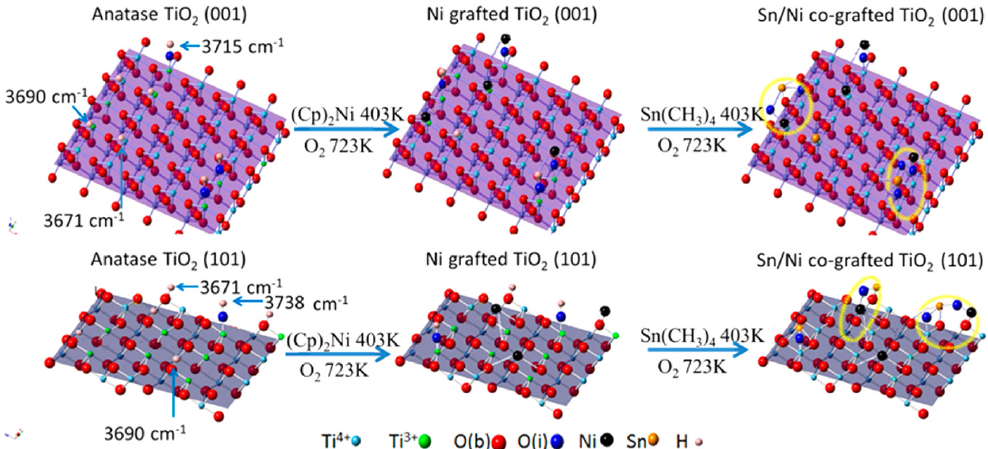
Figure 4. The schematic mechanism for the proposed formation of titania modified with Sn/Ni. Copyrights 2015 ACS. [71].